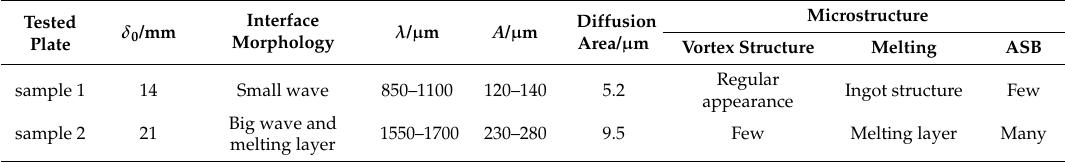
Figure 5. Energy spectrum analysis for bonding zones of sample 1 (marked points A and B) and sample 2 (marked points C and D). Table 2. The results of the microstructure investigation.